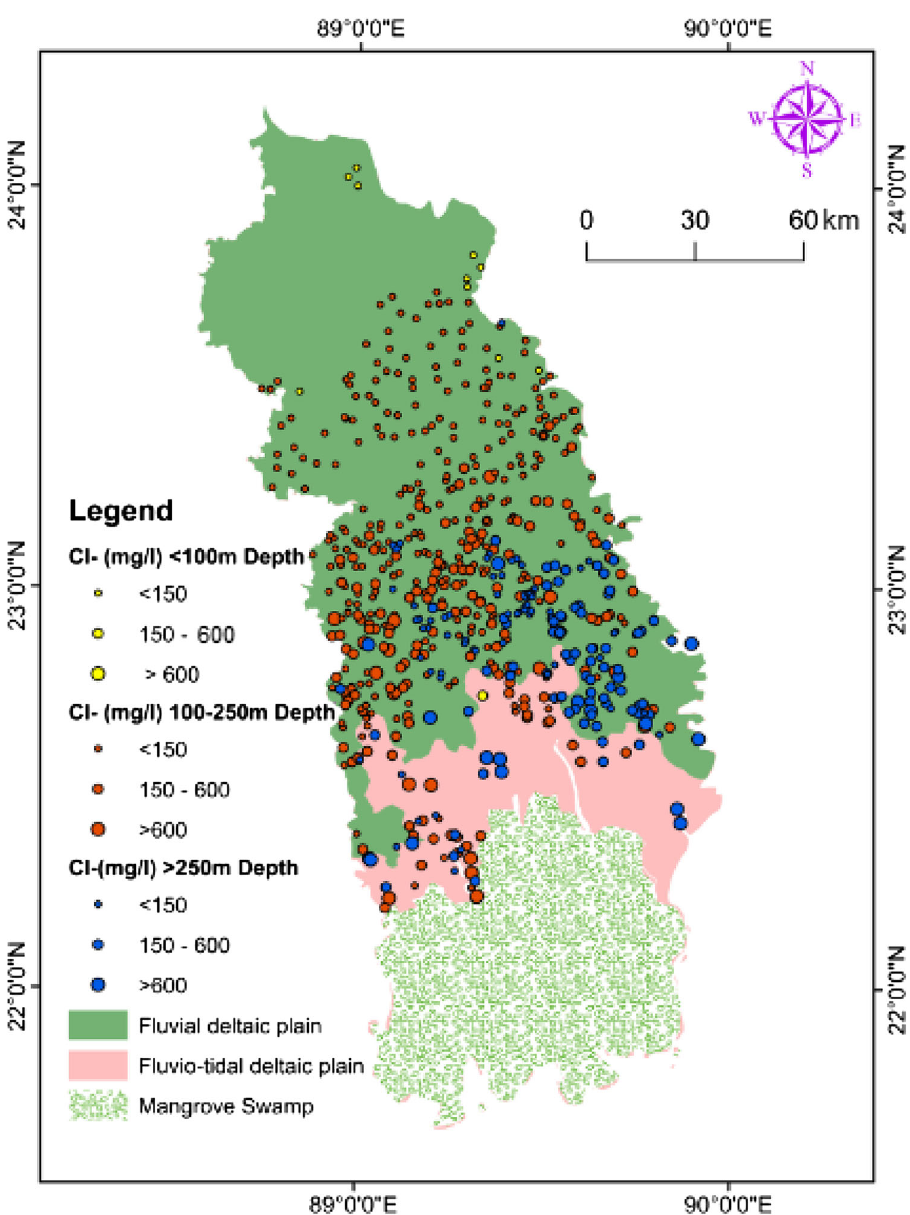
Fig. 8 Spatial distribution map of chloride concentrations at various depths in relation to